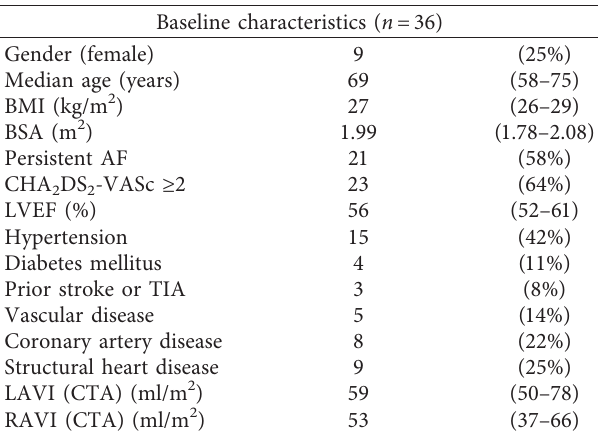
Figure 1: High-density electroanatomic bipolar voltage maps of two representative patients (posteroanterior (PA) view). Patient 1, an example with low amount of the low-voltage area (Quartile 1, Q1) in the left atrium (LA) and right atrium (RA). Patient 2, an example with Quartile 4 (Q4) diseased tissue of the left and the right atrium. Table 1: Baseline patient